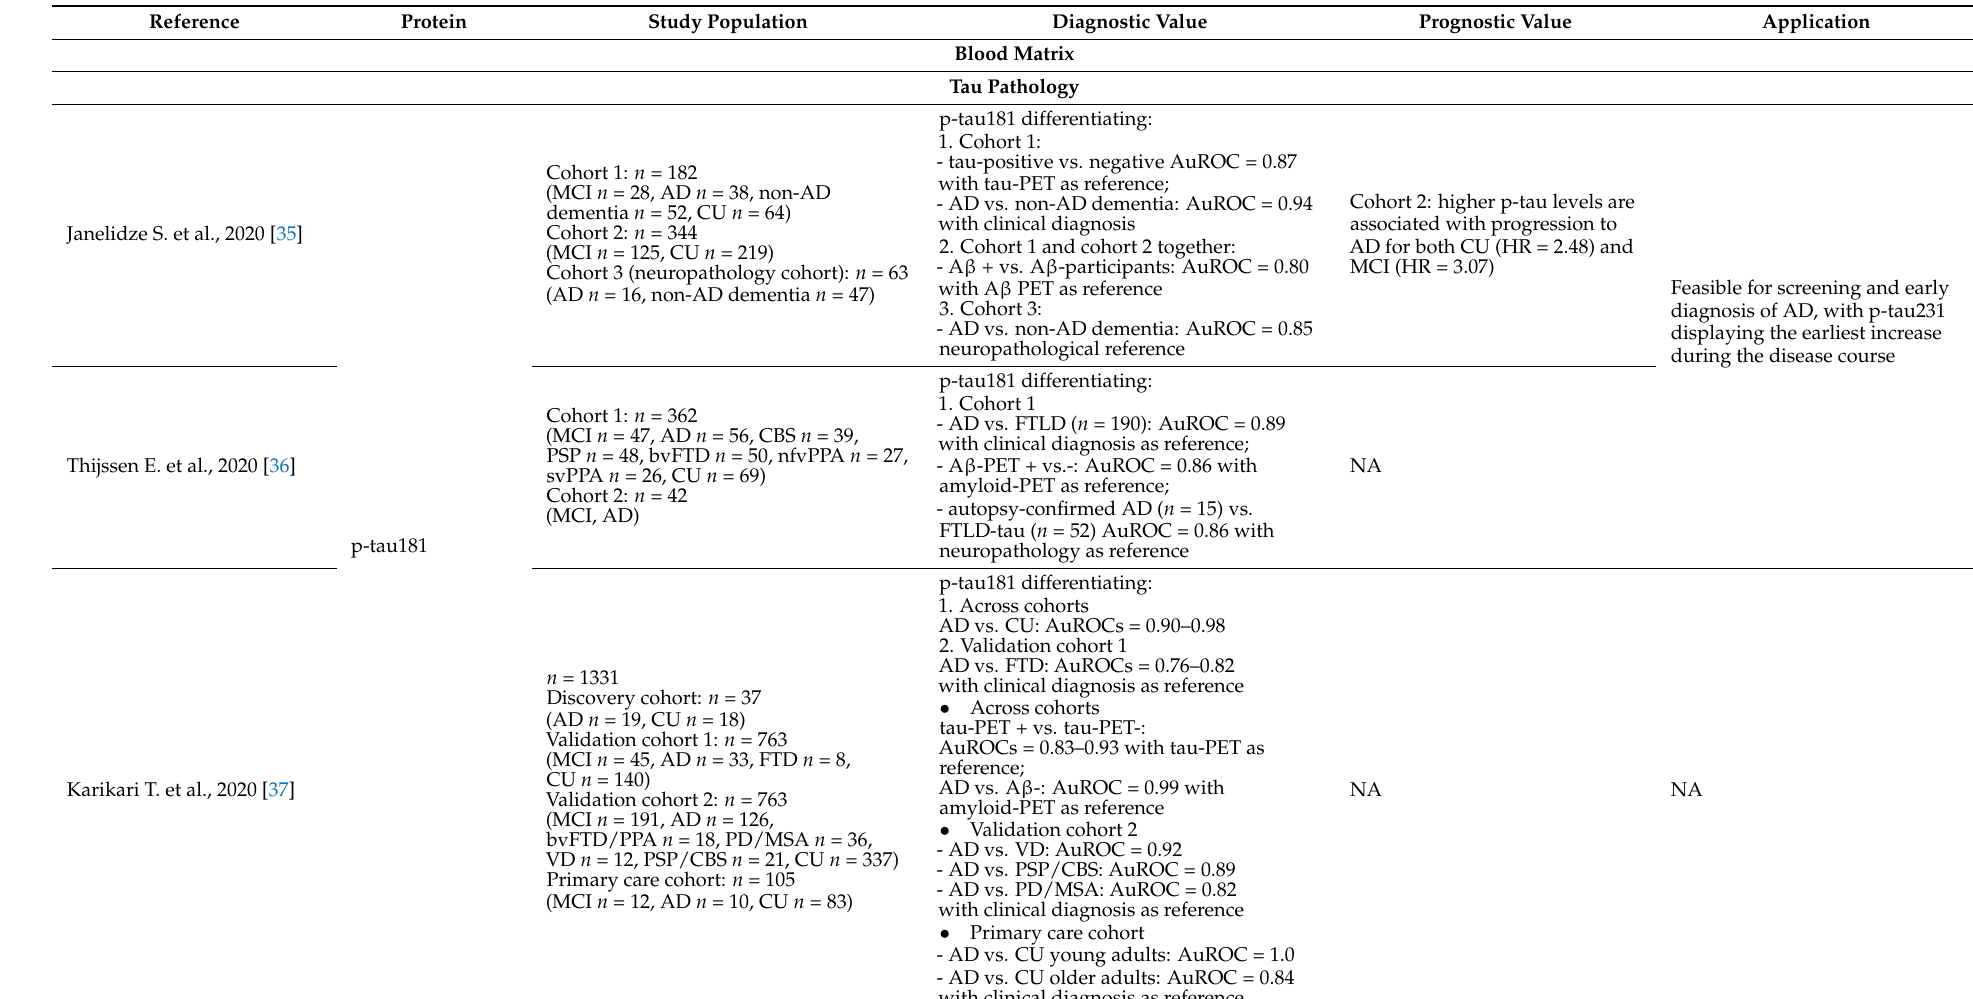
Table 1. Overview on the diagnostic/prognostic values and putative contexts-of-use of novel fluid biomarkers for